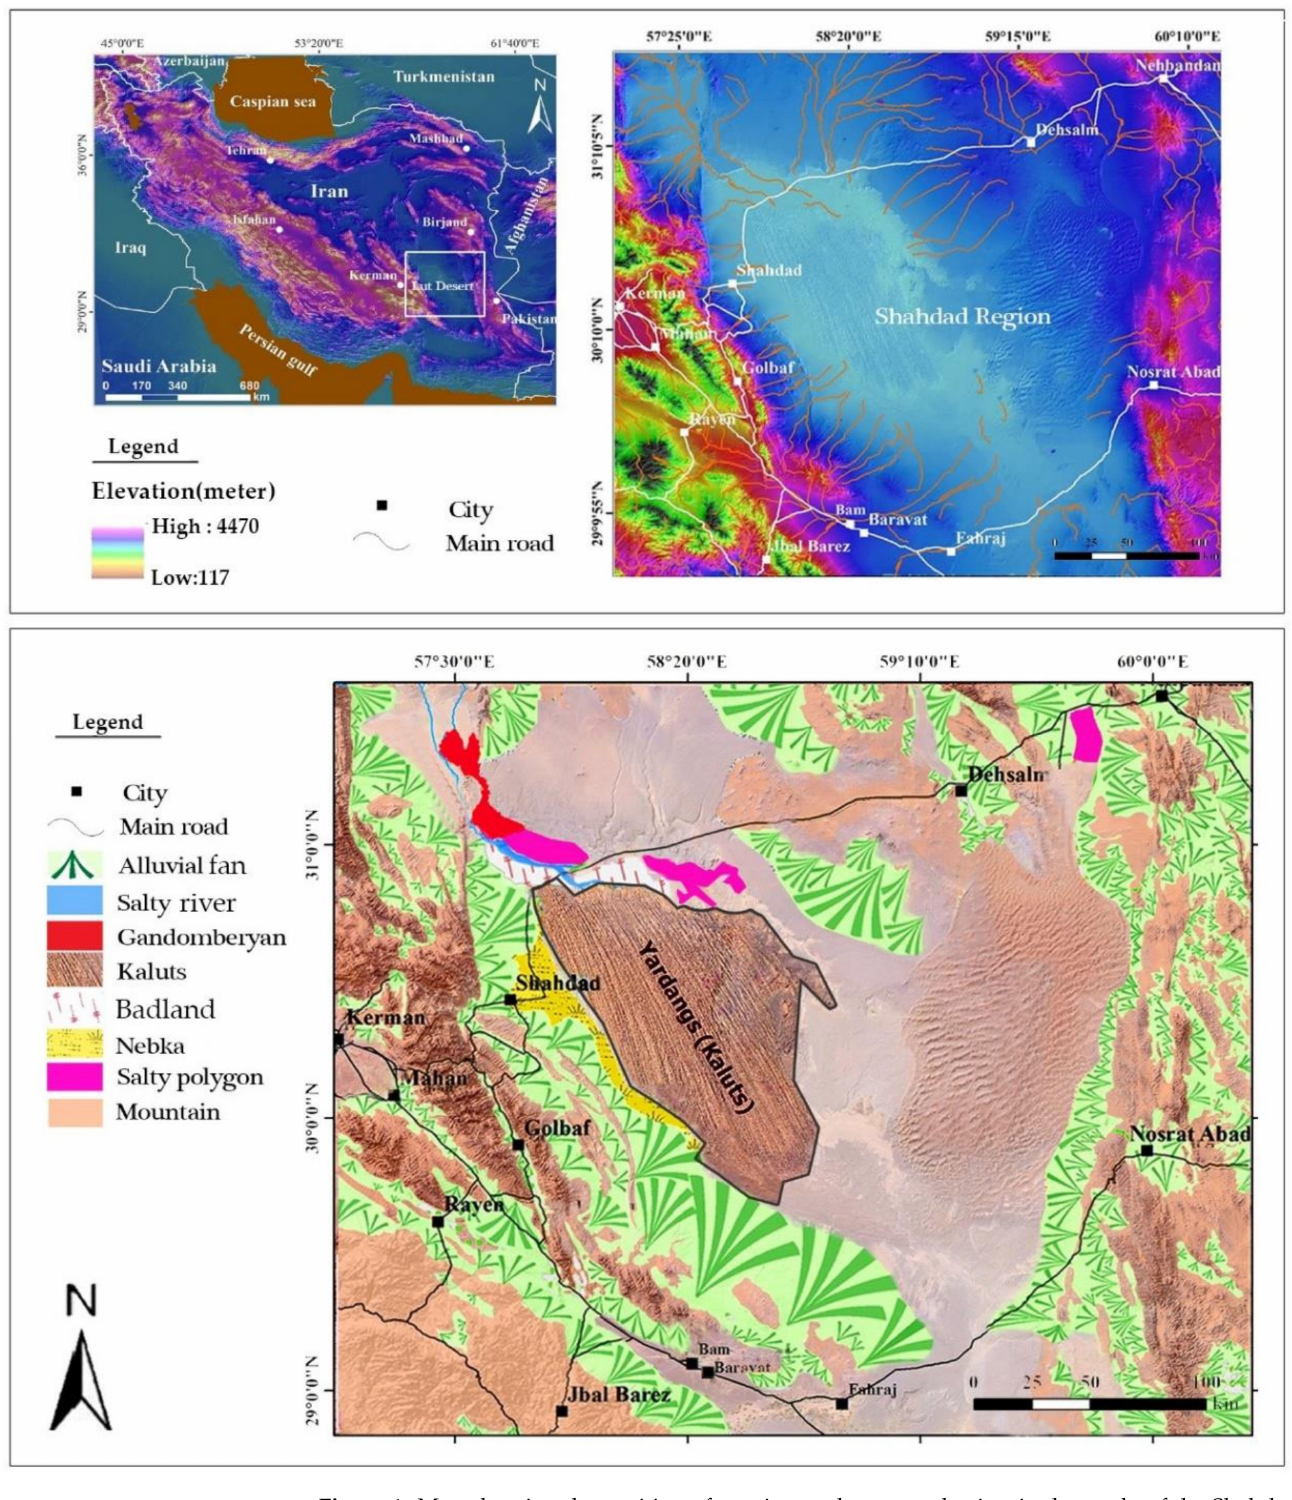
Figure 1. Map showing the position of geosites and geomorphosites in the study of the Shahdad region. In the medallions are satellite images of the position of the Lut Desert in Iran (top left) and the Shahdad region in which the study area is located (top right). (Source: